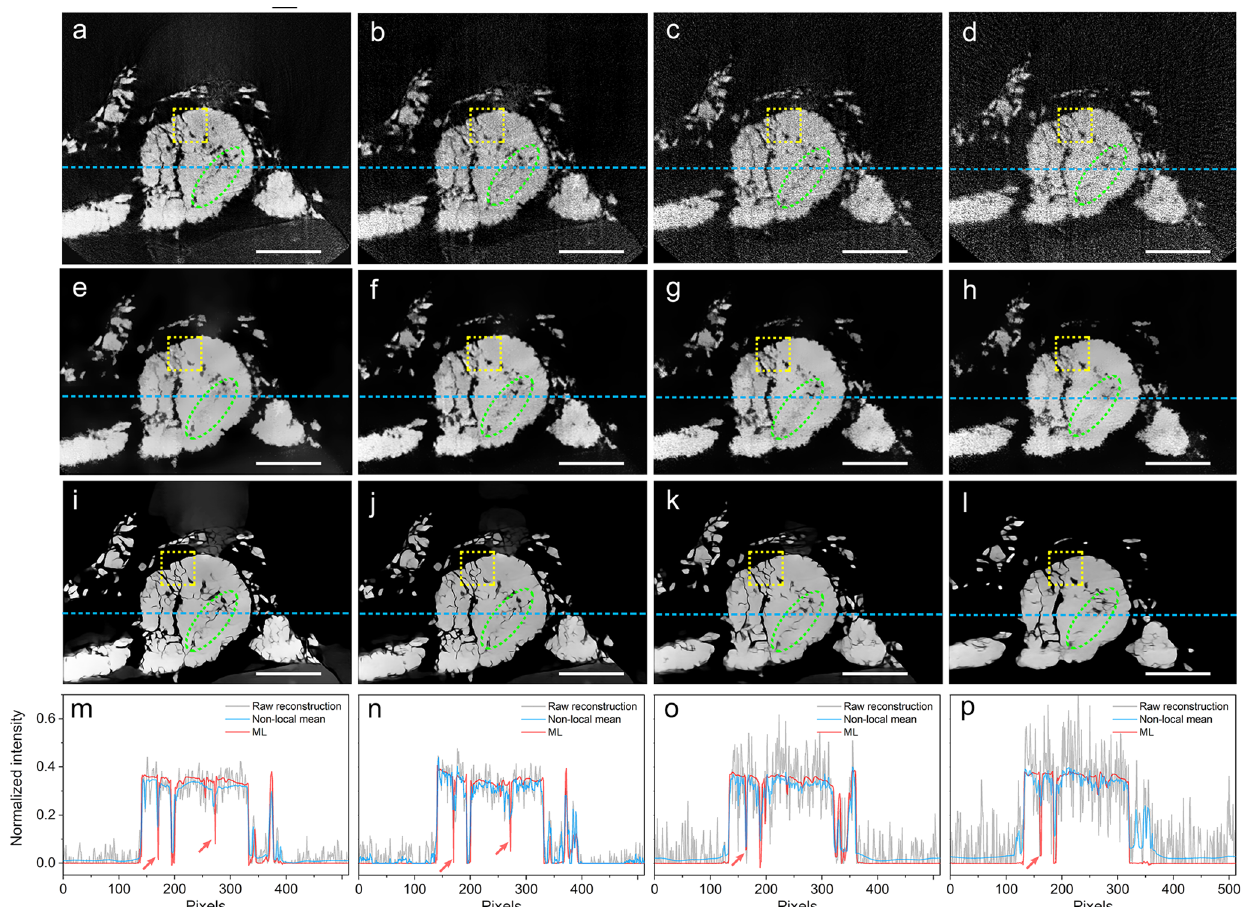
Fig. 4 TXM tomography of LiNi 0.5 Mn 0.3 Co 0.2 O 2 . a – d 2D slice extracted from 3D reconstruction at experiment conditions of: ( a ) 3 deg s − 1 , 1200 projections. b 10 deg s − 1 , 360 projections. ( c ), 20 deg s − 1 , 180 projections. d 30 deg s − 1 , 120 projections. e – h The output of denoising using non-local- mean implemented in ImageJ for images in ( a – d ). i – l Machine learning outputs of ( a – d , respectively. Scalebar is 5 μ m. The area enclosed by the yellow square and green ellipse are highlighted for reconstruction quality comparison. m – p Line pro fi les at the position indicated as the dashed blue evolution. Figure 5a – l shows the morphology changes at different temperatures: room temperature, initial reach to 700 o C, keep at 700 o C for 5 min, and reach to 800 o C. During the heating process, surface (Fig. 5a – d). From a slice view of the reconstructed